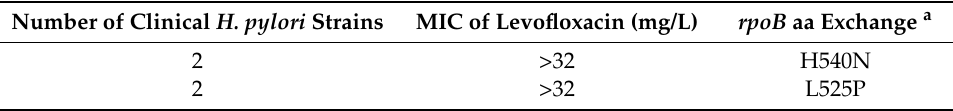
Table 5. Amino acid exchanges identified by WGS in the RRDR of the rpoB gene conferring resistance to rifamycins and their corresponding MICs.